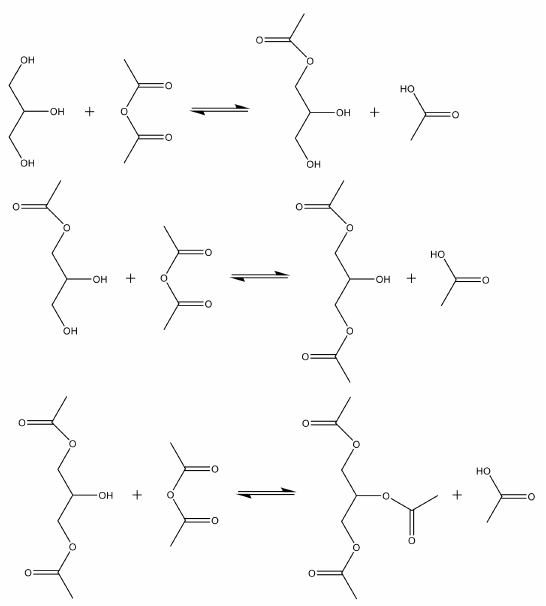
Figure 28. Ester yield obtained in wasting cooking oil transesterification reaction over 25 wt% H 3 PW 12 O 40 catalyst. Reaction conditions: used cooking oil (0.115 mol), methyl alcohol (2.069), temperature (150–225 ◦ C) (adapted from